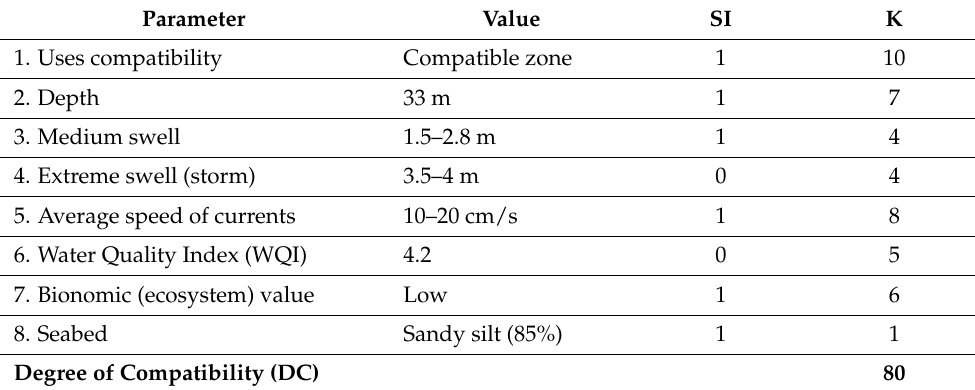
Table 8. Scores of the parameters used for calculating the DC for the AZA designation for finfish farming in the Mangalia